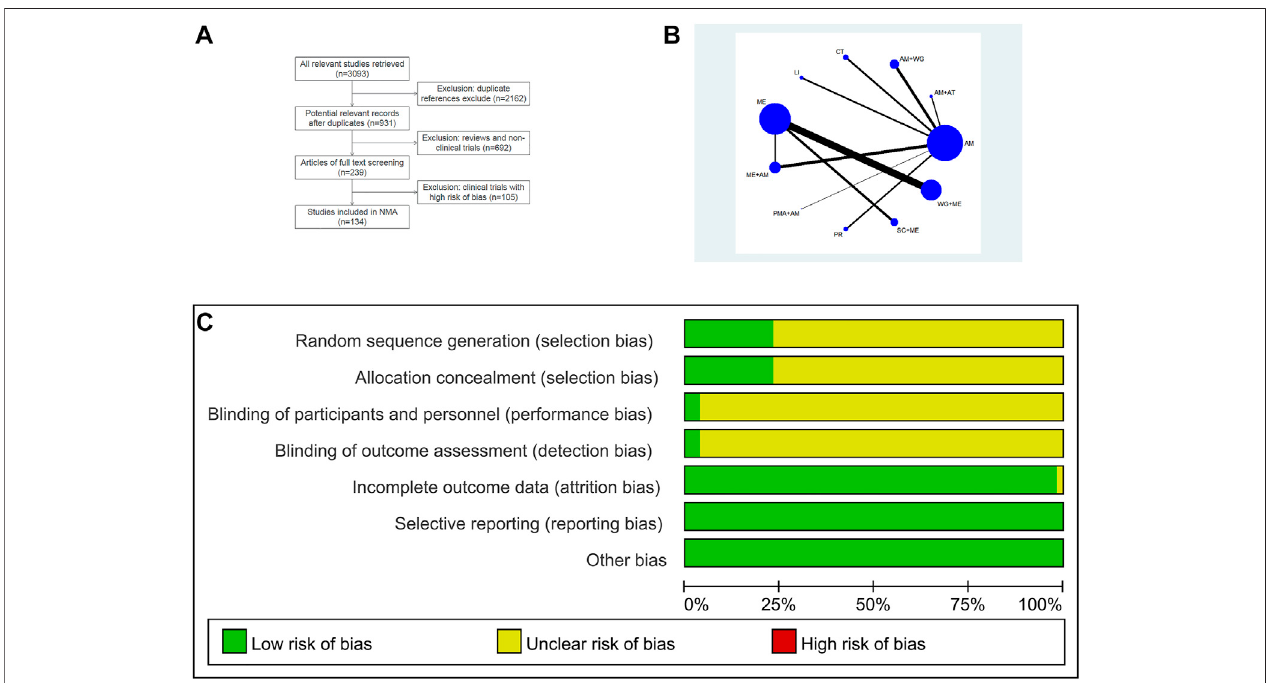
FIGURE 1 | (A) Flowchart of studies selection; (B) Network of comparisons included in the analysis; (C) Methodological quality assessment of the risk of bias for included studies.